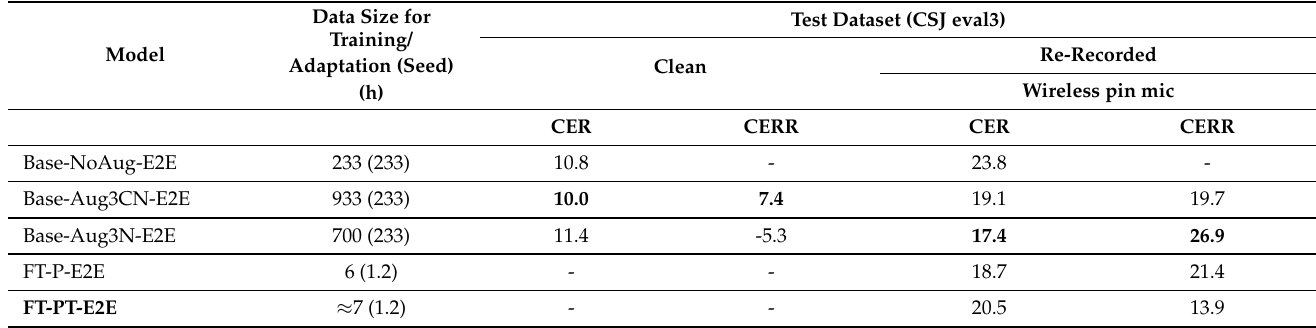
Table 8. Wireless pin mic speech: character error rate (CER%) of different E2E ASR models and character error reduction (CERR%) from Base-NoAug-E2E. The notation “-” denotes “not applicable”. The expressions with bold font represent the models trained with proposed fine-tuning method. The bold numbers represent the best result for each test